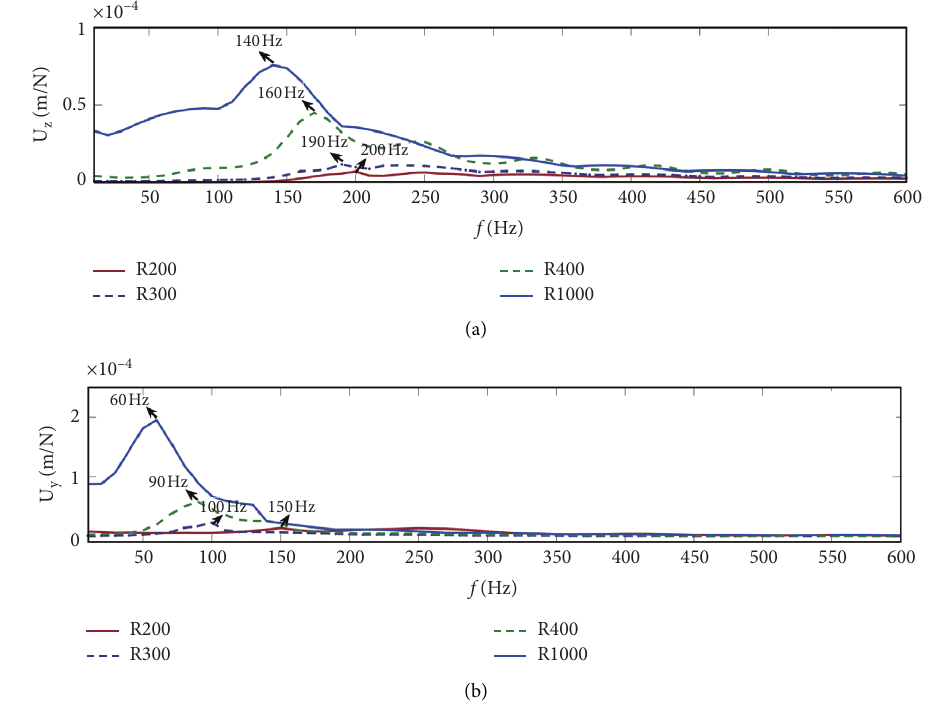
Figure 5: Receptance of the inner rail for different track radii (a,